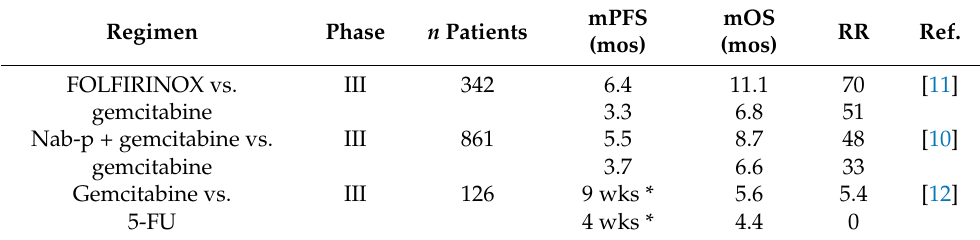
Table 1. First-line regimes in metastatic